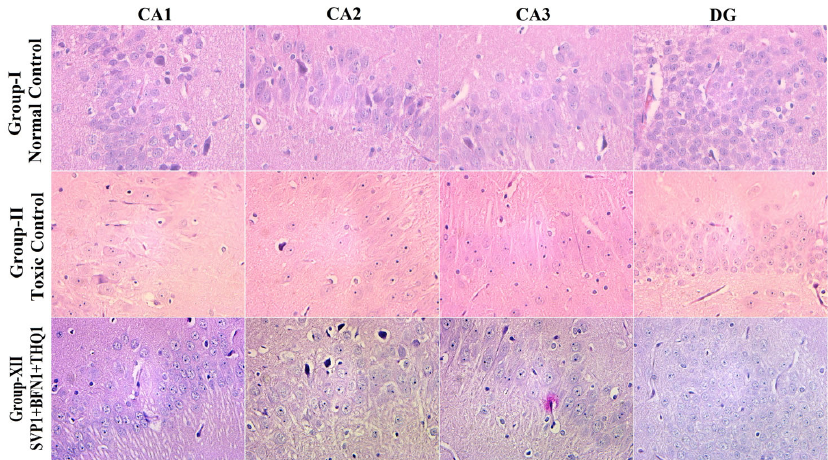
Figure 5. The H/E-stained hippocampal section visualized under 40 × shows normal arrangements and distributions in the normal control group (Group-I). Plenty of neuronal loss, degeneration and death from electroshock observed in Group-II. Slight cellular changes in CA1, CA2, CA3, DG of the SVP (150 mg/kg) + BFN (5 mg/kg) + THQ (40 mg/kg) injected rats are indicative of minimal neuronal degeneration and nuclear pyknosis in Group-XII.